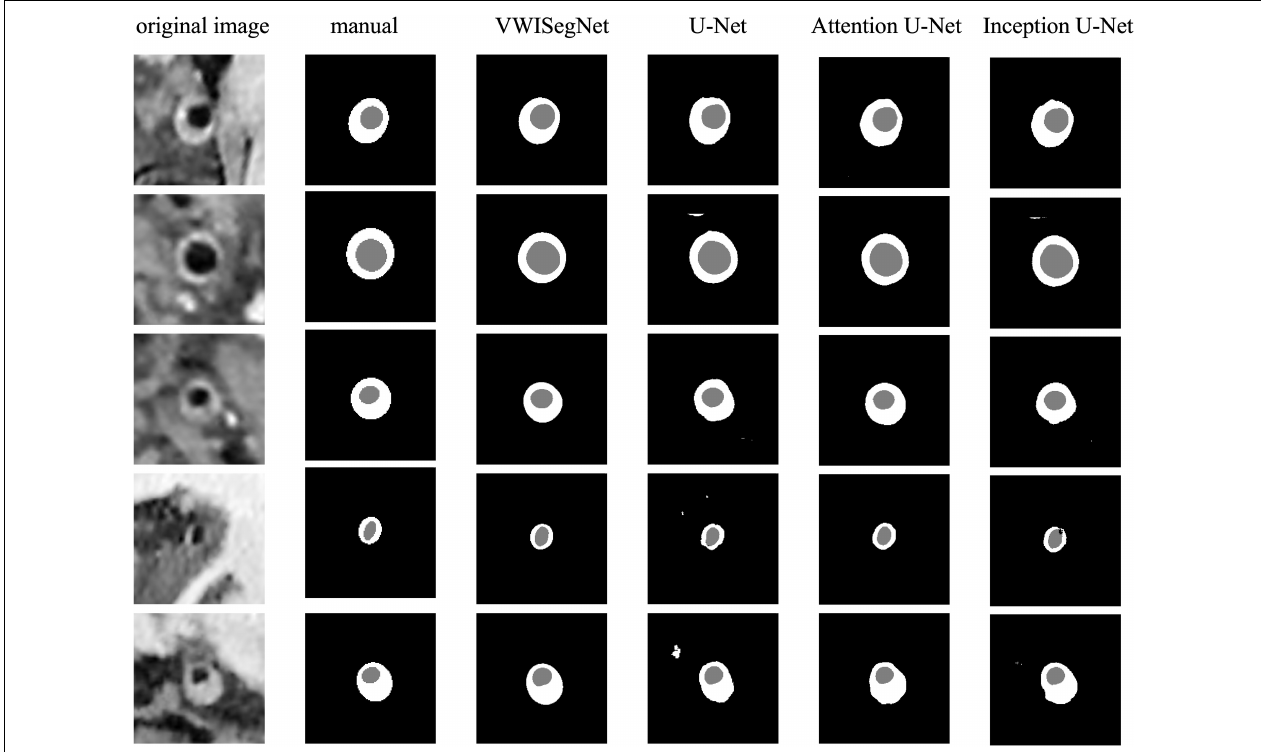
FIGURE 3 | A representative comparison between the proposed VWISegNet and the traditional U-Net, Attention U-Net, and Inception U-Net on the segmentation of vessel wall.